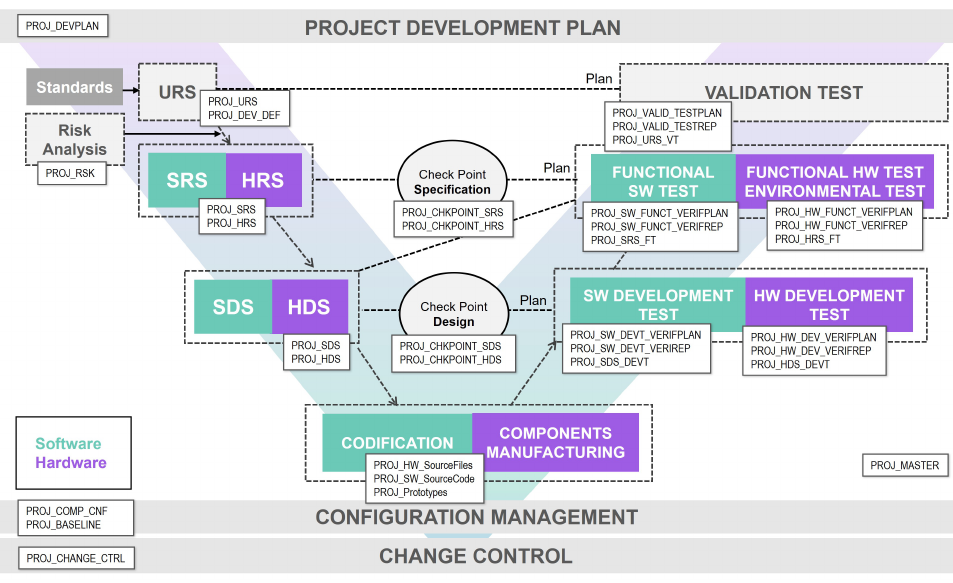
Figure 15. Deliverables associated to the phase